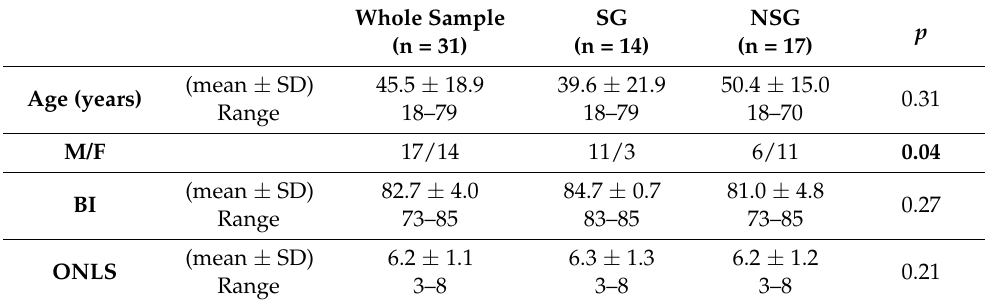
Table 1. Demographical and disability data of the whole sample and in the sport group and no-sport